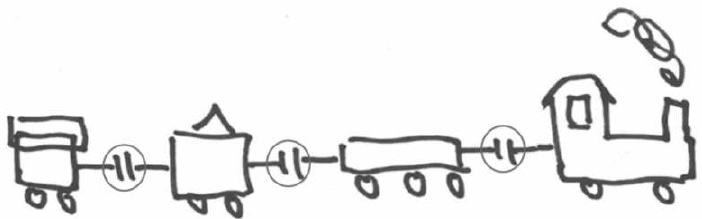
Figure 3. A compound schema (sentence) as built up from different constituents with engaging